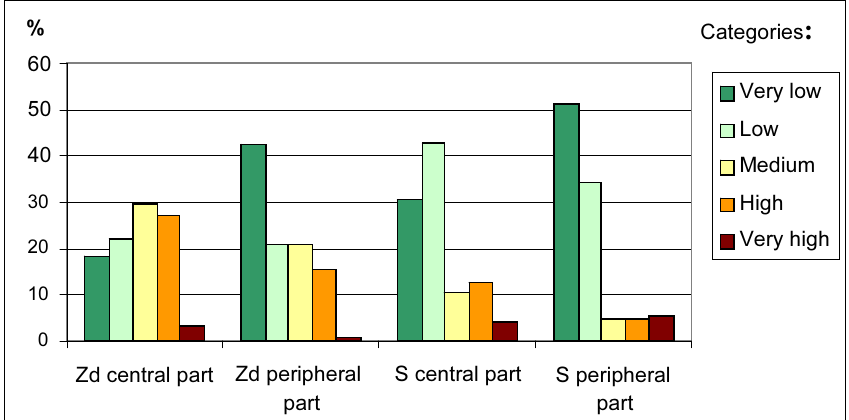
Fig. 3. Percentages of sites belonging to different categories of additive contamination Zd and sensitivity to chemical pollution S in central and peripheral parts